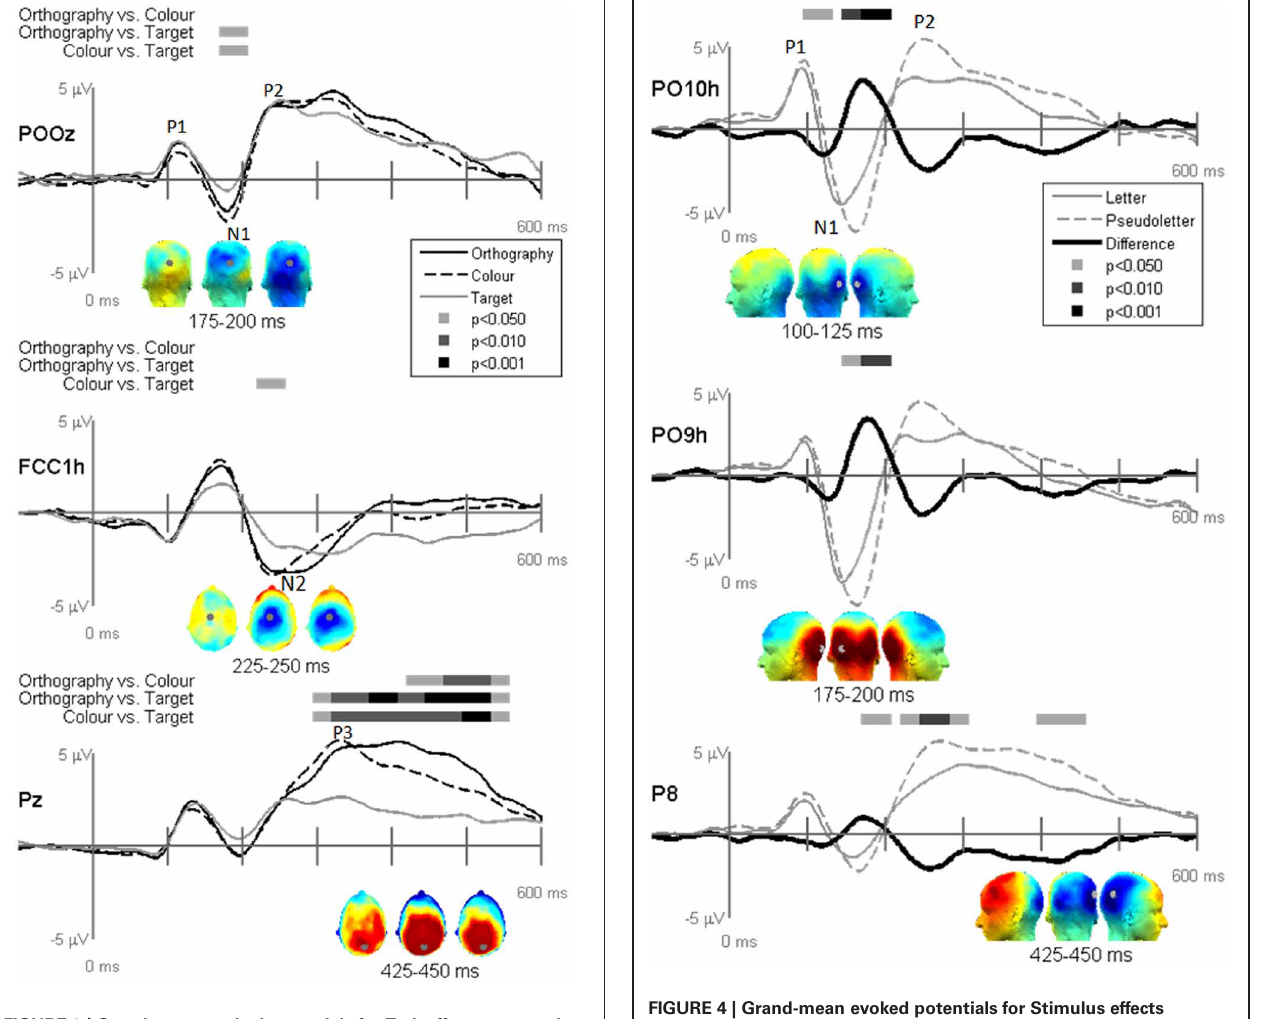
FIGURE 3 | Grand-mean evoked potentials for Task effects averaged across stimulus type (letters and pseudoletters) at electrodes POz, FCC1h, and Pz. Bars above the waveforms designate intervals of significant differences between task comparisons at p < 0 . 05, p < 0 . 01, and p < 0 . 001. Scalp topographies plotted under the waveforms reflect the task contrasts of Orthography vs. Color, Orthography vs. Target, and Color vs. Target going from left to right. The topographies for the Task effects between 175–200 ms are shown for a posterior view and the topographies for the Task effects between 225–250ms and 425–450 ms are shown for a top view (nose pointing to top of page). The gray dots in the topographies reflect the electrode location for the waveforms plotted above.